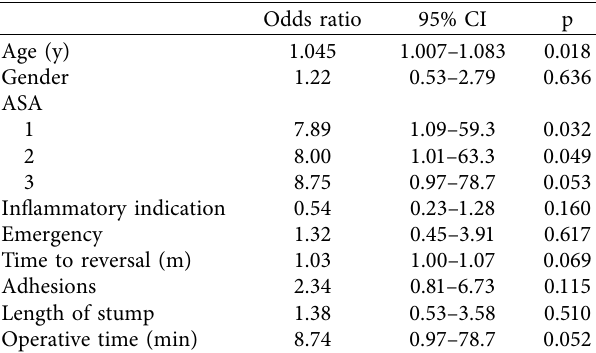
Figure 1: Time elapsed between HP and HR in the four grades of adhesions. Table 2: Risk factors for complications (Clavien-Dindo 2 or